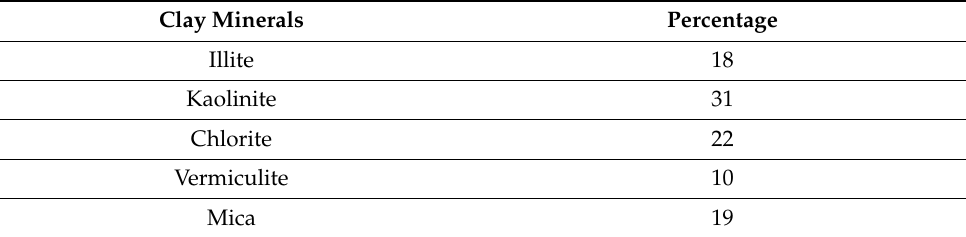
Table 3. Clay (Content) mineralogy of shale samples (XRD analysis). Clay